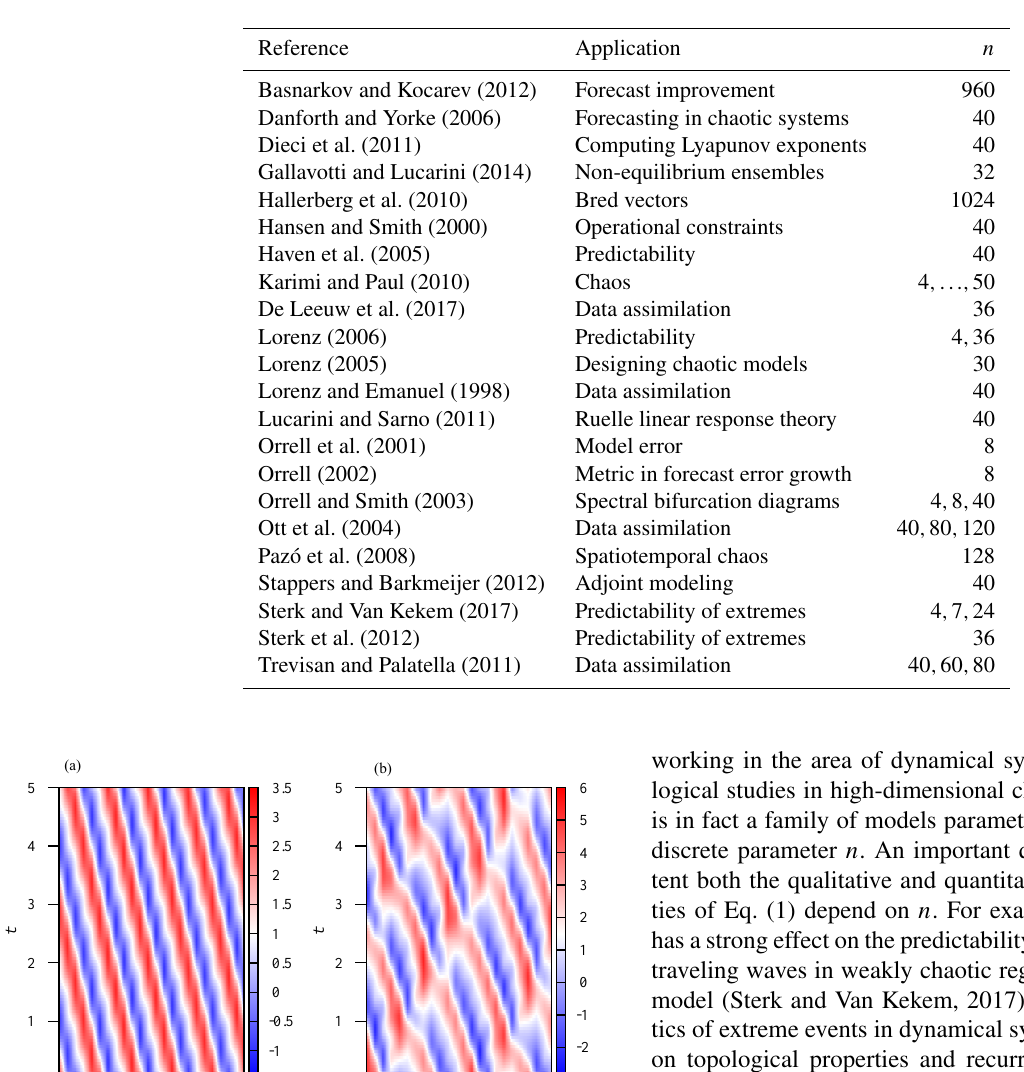
Table 1. Recent papers with applications of the Lorenz-96 model and the values of n that were used.